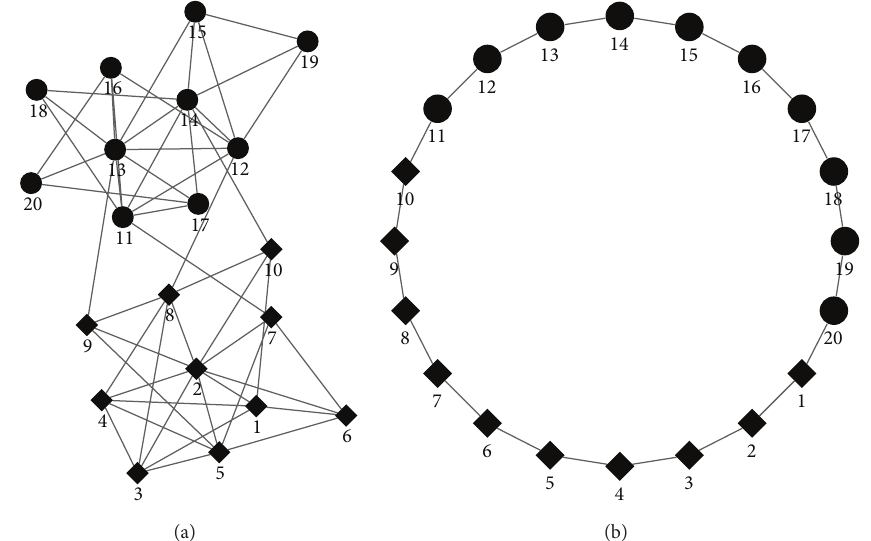
Figure 1: The controlled complex network (41). (a) The topological structure of matrix A . (b) The topological structure of matrix B .